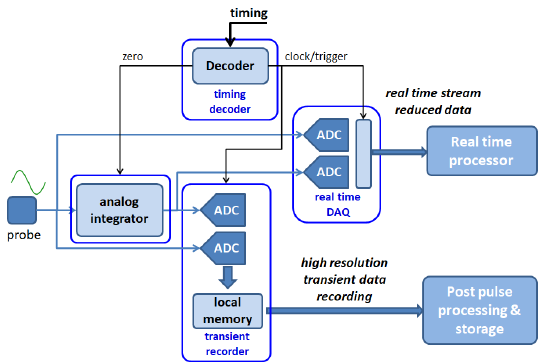
Figure 23. Block scheme of the legacy architecture of RFX-mod. Each function is carried out by a separate dedicated hardware